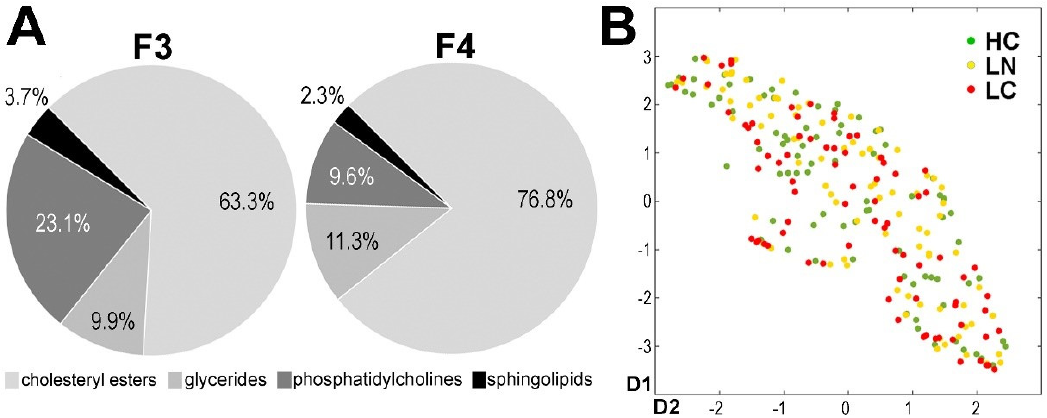
Figure 2. Characteristics of lipid profiles in sEV. ( A ) Relative contribution of major classes of lipids in sEV fractions F3 and F4 (polled samples obtained from sera of 4 healthy donors were analyzed); ( B ) the global structure of the whole sEV lipid dataset. A spatial visualization was created using the UMAP data transformation from 352-dimensional metabolic space to 2D view, preserving the structure of the high-dimensional data to illustrate the potential sample clustering (HC—healthy controls; LN—benign lung nodules; LC—lung cancer).